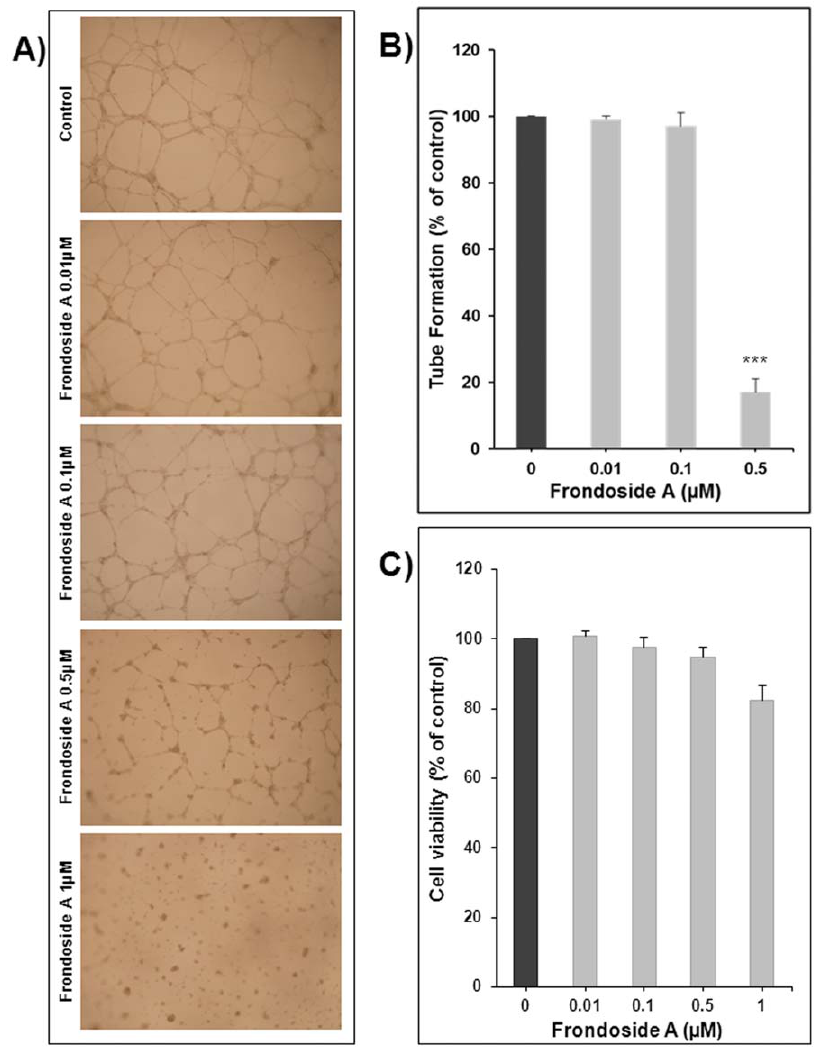
Figure 7. Impact of Frondoside A on the formation of capillary-like structures by HUVECs invitro . A ) Patterns of angiogenesis induced by human umbilical vein endothelial cells (HUVEC) cultured on Matrigel matrix in 96-well plates in the absence or presence of the Frondoside A. B ) Quantification of tubular morphogenesis induced in HUVEC cells cultured in the absence or presence of Frondoside A. Tube formation was determined by the length of tube-like structures containing connected cells. Data are mean 6 S.E.M. from three separate experiments. Asterisks indicate that significantly different values were obtained in the presence of the indicated inhibitors vs. the corresponding control stimulation. *** Significantly different at P , 0.001. C ) HUVEC cells were treated with vehicle (0.1% DMSO) and the indicated concentrations of Frondoside A. Viable cells were assayed as described in Materials and Methods. All experiments were repeated at least three times. Columns , mean; bars , S.E.M.